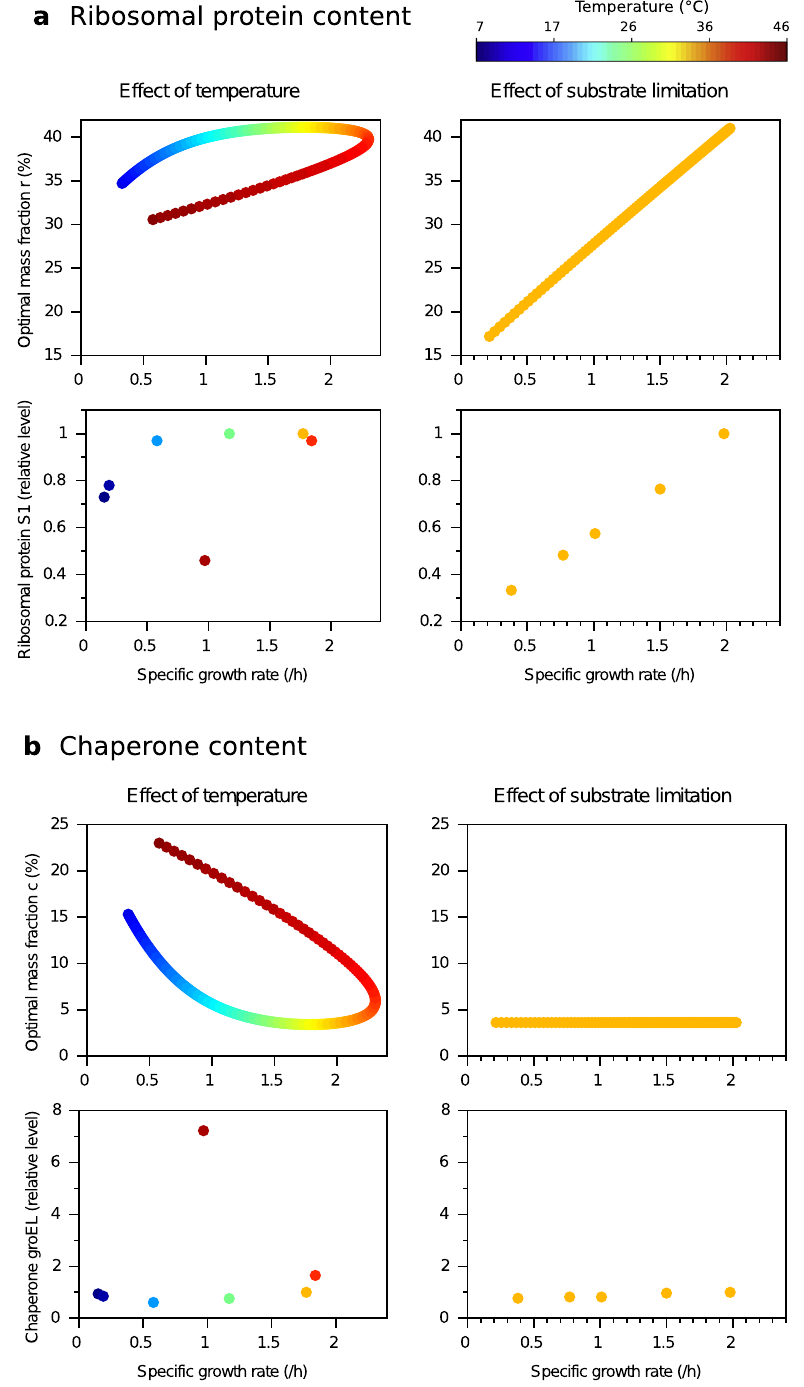
Fig. 3 Protein sector content for ribosomal proteins and chaperones as a function of speci fi c growth rate, varying with temperature (left) or substrate limitation (right). a Ribosomal protein mass fraction. Top: model prediction. Down: Level of the ribosomal protein S1 in E. coli for different temperatures in glucose rich medium (left), and for different media at 37 ∘ C, relative to glucose-rich medium at 37 ∘ C 22,36 . For each point, color represents temperature (see colorbar). b Chaperone mass fraction. Same legend as ( a ) for the chaperone